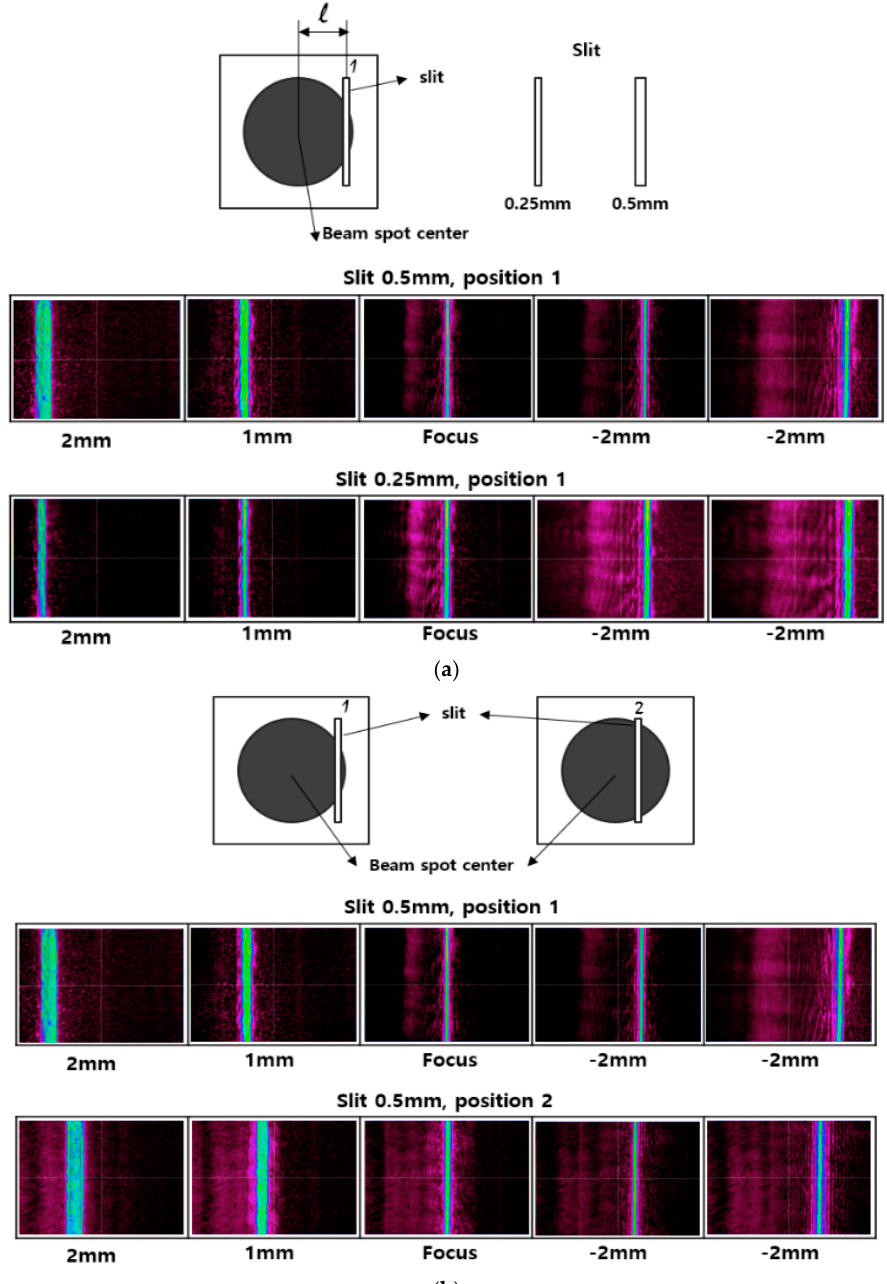
Figure 4. Comparison of variations in slit image position on the CCD camera when the specimen is positioned at the focus and at different defocus distances for ( a ) different slit widths (0.25 mm and 0.5 mm) with the same distance (cid:1864) , and for ( b ) the same slit width with different distances (cid:1864) (with the slit relatively close to or far from the beam spot center). 0.5 mm) with the same distance l , and for ( b ) the same slit width with different distances l (with the slit relatively close to or far from the beam spot